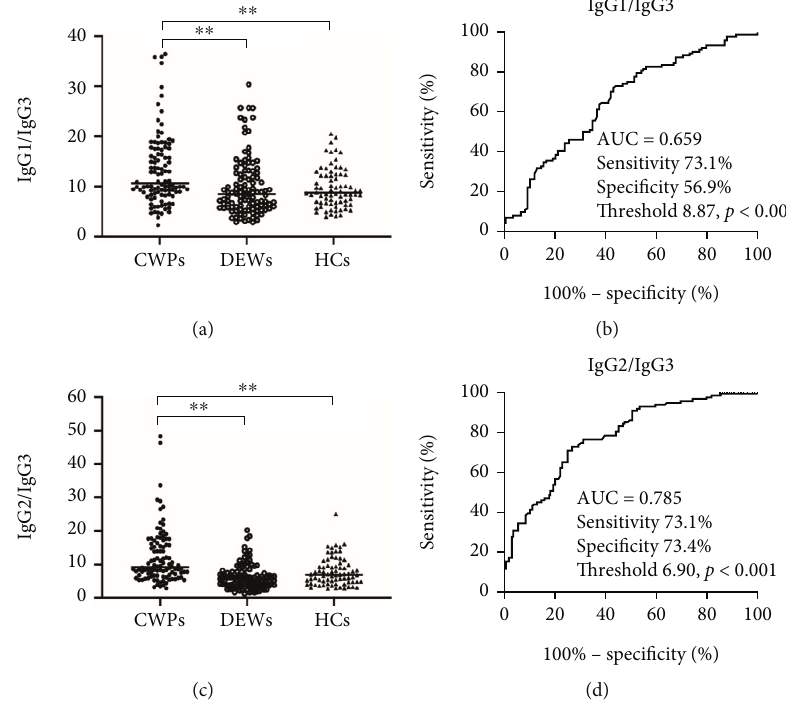
Figure 3: Comparison of the IgG1/IgG3 ratio and IgG2/IgG3 ratio among the study groups. (a) IgG1/IgG3. (b) ROC analysis was performed for IgG1/IgG3 to determine the threshold value for di ff erentiating between CWPs and DEWs. (c) IgG2/IgG3. (d) ROC analysis was performed for the E IgG2/IgG3 ratios to determine the threshold values for discriminating between CWPs and DEWs. ∗∗ P < 0 : 01 . CWP: coal workers ’ pneumoconiosis; DEWs: dust-exposed workers. ROC: receiver operating characteristic.